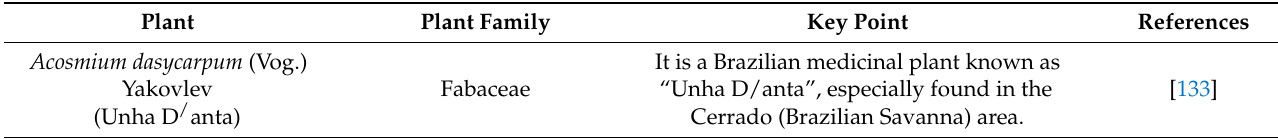
Table 1. Anti-obesity potential of some medicinal plants and